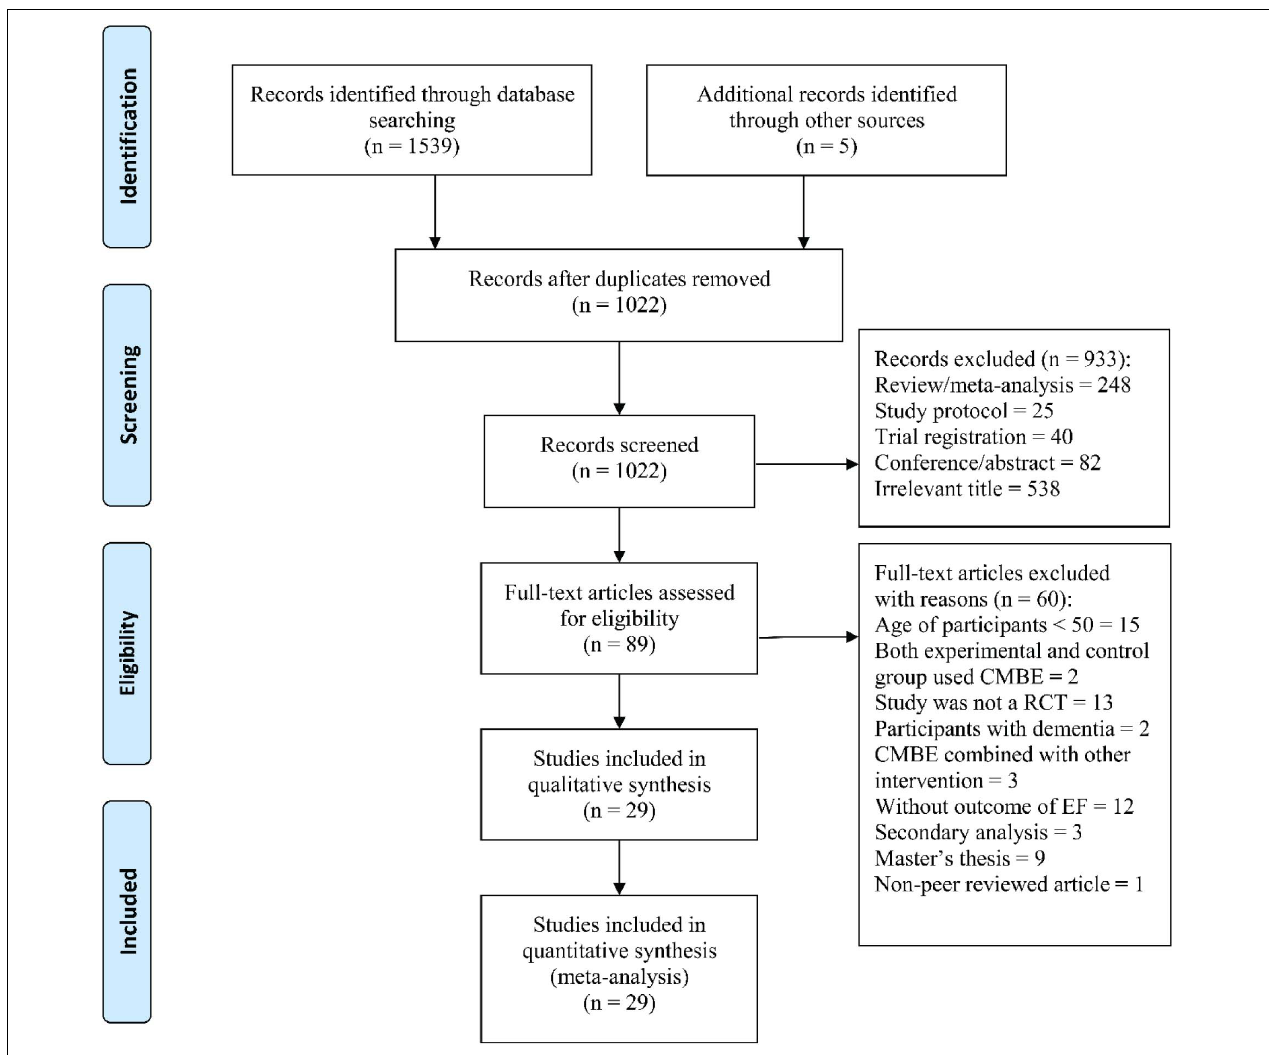
FIGURE 1 | Preferred Reporting Items for Systematic Reviews and Meta-Analyses flow chart of the study identification and selection process. CMBEs, Chinese mind-body exercises; RCT, randomized controlled trial; EF, executive function; n ,